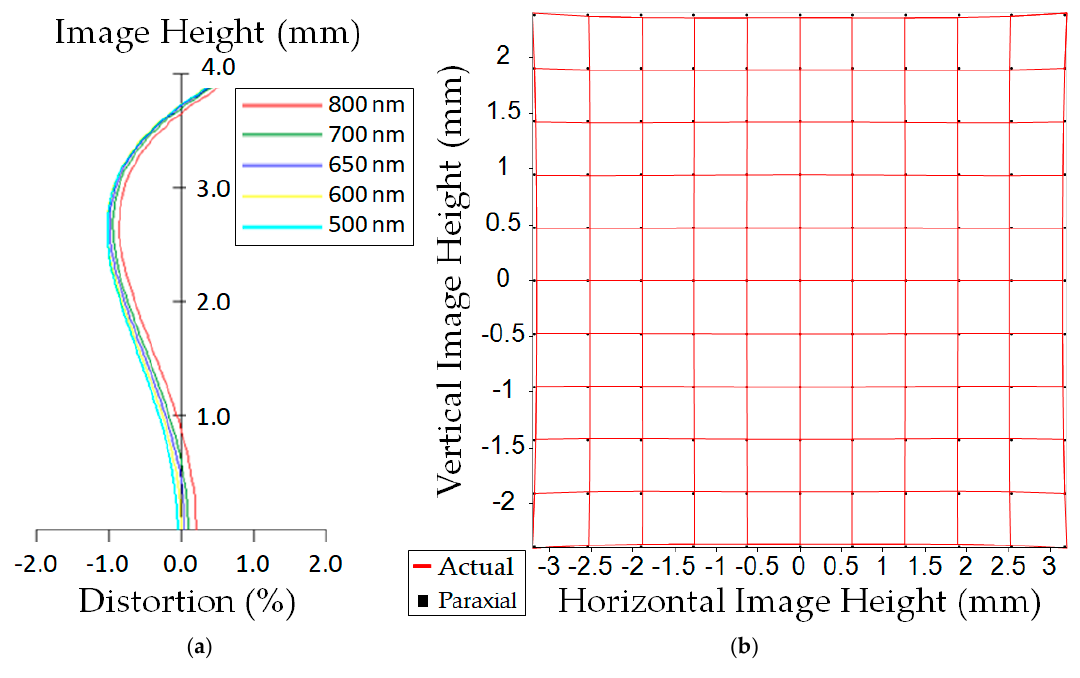
Figure 6. ( a ) Distortion curve and ( b ) distortion grid of the lens module.